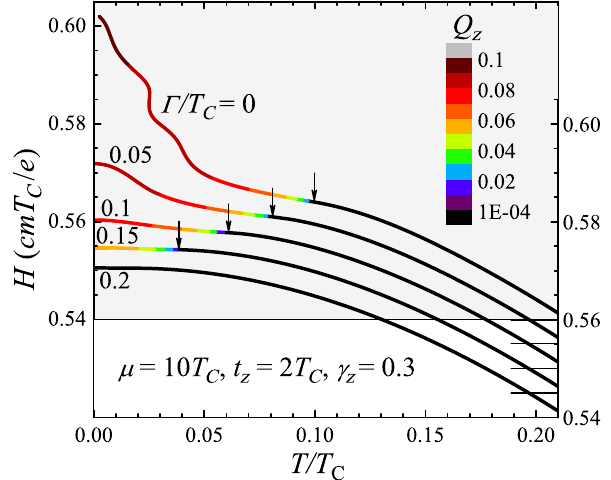
9.FIG. 9. Evolution of the upper critical field line with increasing the impurity broadening Γ . The plots are vertically displaced for clarity [the left-axis (right-axis) labels correspond to the upper (lower) curve]. The used electronic parameters are shown in the plot. Arrows mark the locations of the FFLO transitions. For these parameters, at Γ ¼ 0 . 2 T the FFLO state is C